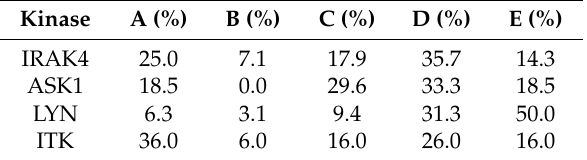
Figure 3. Superimposed TWNs around staurosporine in the IRAK4 binding pocket. We divided the ATP binding site into five regions (A–E) based on staurosporine’s binding mode, to analyze TWN patterns. Three-, four-, five-, and six-membered water rings are represented by red, yellow, blue, and purple spheres, respectively. The D site with a unique water network pattern is highlighted using a black dashed circle. Table 1. Percentage of water networks in various regions (A–E) for IRAK4, ASK1, LYN, and ITK. Kinase A (%) B (%) C (%) D (%)